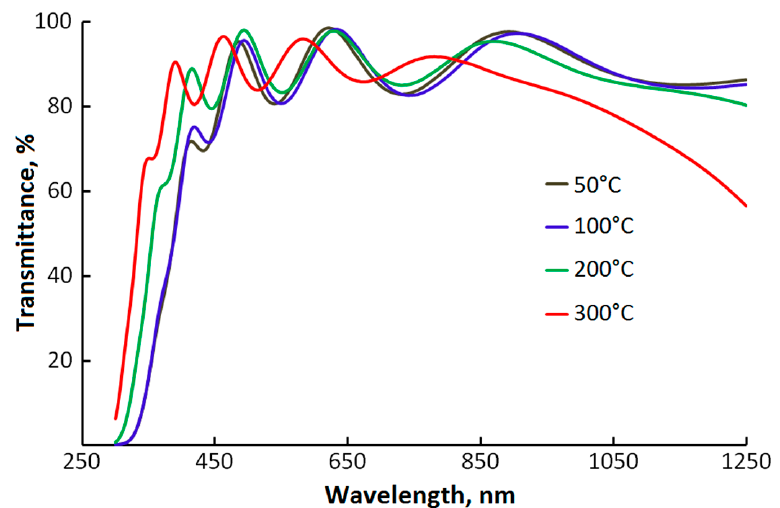
Figure 4. Transmittance spectra in the 300–1250 nm region for ITO thin films deposited at various substrate temperatures (glass substrate contribution